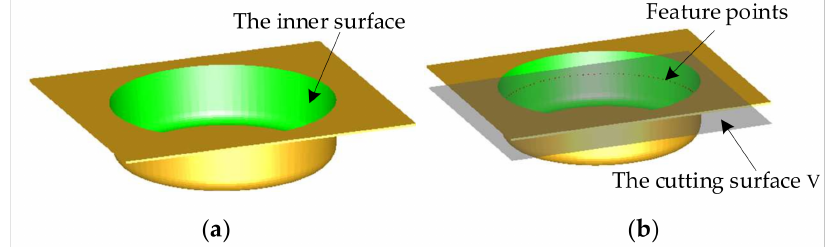
Figure 13. Feature points generation: ( a ) the inner surface extraction; ( b ) the cutting surface and feature points.